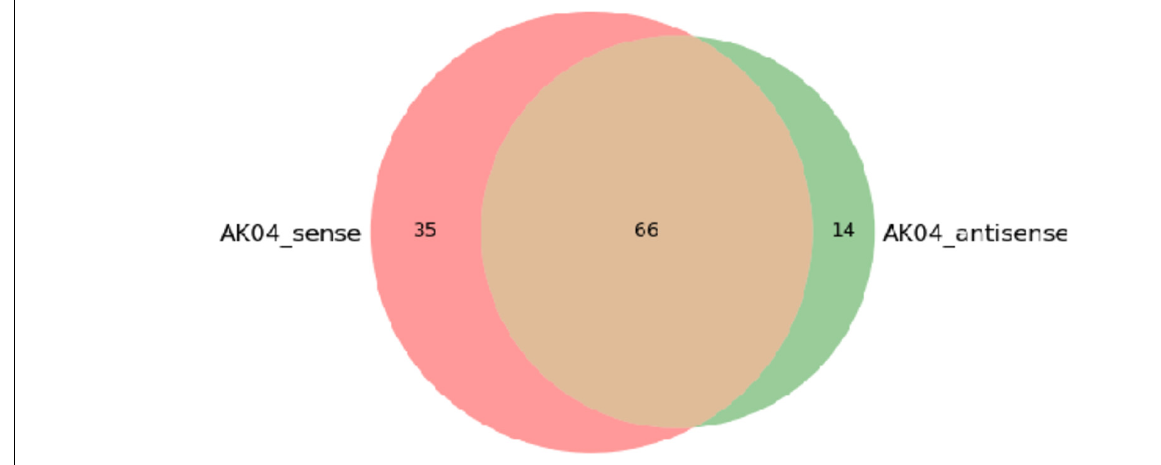
FIGURE 10 | AK04 sense-AK04 antisense Venn diagram between two samples.